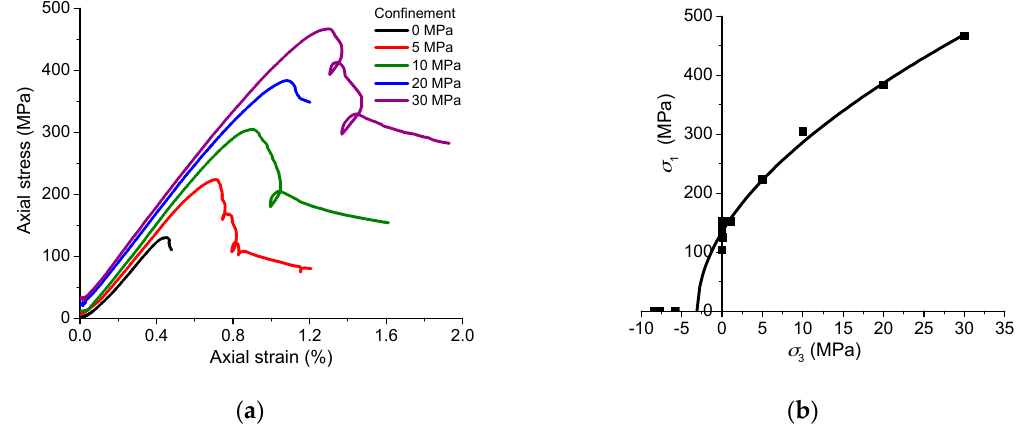
Figure 2. ( a ) Axial stress-stress curves of NRG01 granite samples ( σ 3 = 0 to 30 MPa) and ( b ) Hoek–Brown fitted envelopes based on the test results of NRG01 samples under different confinements.